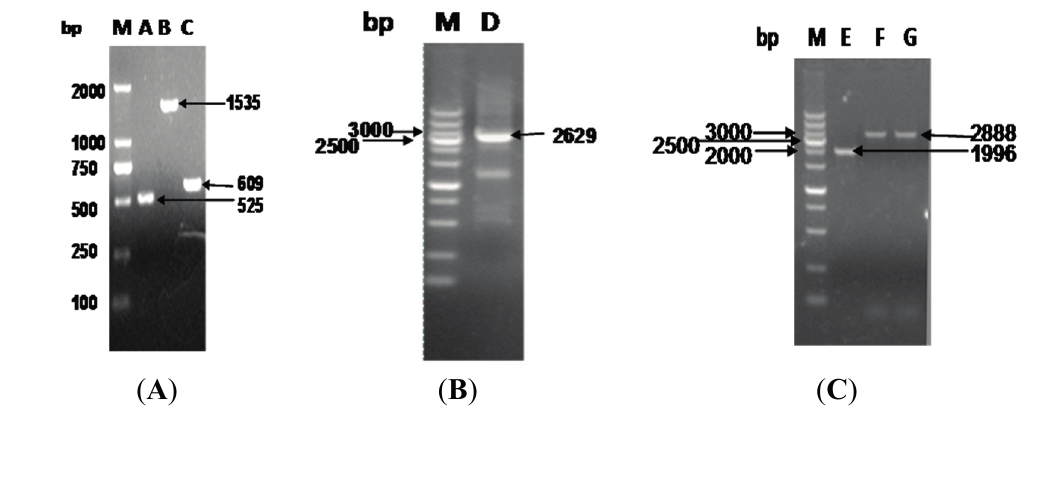
Figure 8. Δ phoN2 was constructed by a modified version of the lambda red